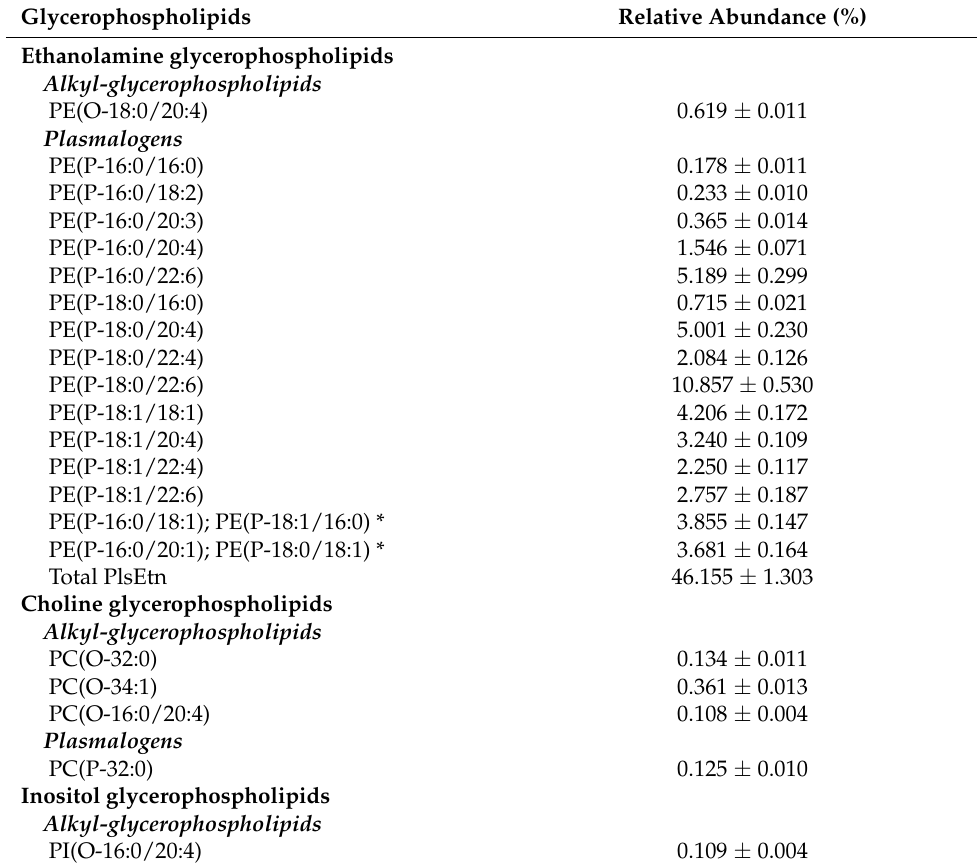
Table 2. Relative amounts of alkyl-glycerophospholipid and plasmalogen species in the different classes of glycerophospholipids measured in mouse cerebral